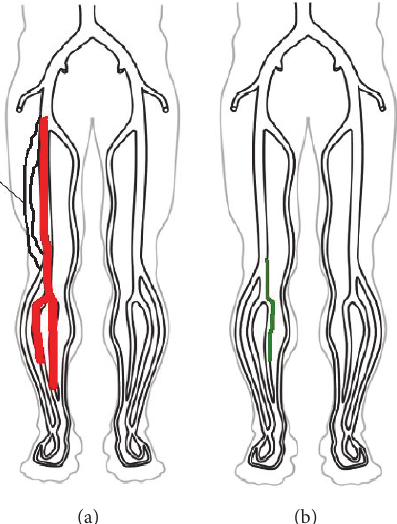
Figure 1: (a) The lower extremity venous Doppler study on the day of admission showed acute deep venous thrombosis in the right common femoral, femoral, popliteal, posterior tibial, and peroneal veins. (b) The lower extremity venous Doppler study five months after discharge showed chronic deep venous thrombosis in the right popliteal and peroneal veins.